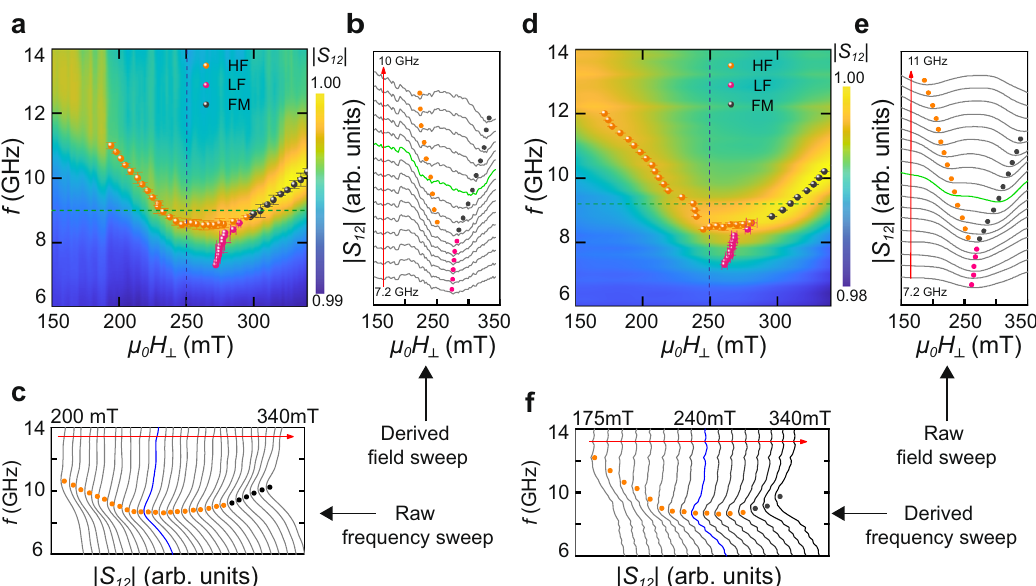
Fig. 2 Experimental microwave absorption spectra of [Ir 1 Fe 0.5 Co 0.5 Pt 1 ] 20 measured by frequency and fi eld-sweep ferromagnetic resonance techniques at room temperature. a Transmission intensity S 12 ( f , H ⊥ ) (colour map) determined from frequency-swept S 12 ( f ) curves at a series of constant magnetic fi elds. Resonances (overlaid data points) are determined by Dysonian peak- fi ts in raw S fi ts in interpolated S 12 ( f ) curves ( c ), or Lorentzian peak- 12 ( H ⊥ ) curves ( b ). Black data points track resonances in the ferromagnetic (FM) phase. In the skyrmion phase, the high-frequency (HF) and low-frequency (LF) modes are shown in orange and pink respectively. Blue S 12 ( f ) and green S 12 ( H ⊥ ) curves are cuts along the blue and green dashed lines in the intensity plot. d Similar plots showing S 12 ( f , H ⊥ ) obtained from a separate dataset consisting of fi eld-swept S 12 ( H ⊥ ) curves at a series of constant frequencies. Raw S 12 ( H ⊥ ) curves are shown in ( e ), and derived frequency-swept S 12 ( f ) curves at constant fi eld in ( f ). The error bars in ( a ), ( d ) are obtained from least-square fi ts of raw experimental spectra. Details of the fi tting procedure are included in supplementary section